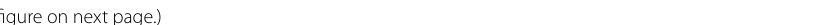
Fig. 2 A 32‑year‑old female diagnosed as RRMS showing multiple plaques; single voxel MR spectroscopy with ROI was placed at corona radiata plaque ( a ); showing decreased NAA curve and mildly elevated choline curve, which is correlated by Low NAA/Cr ratio 1.38 and elevated choline/ Cr ratio 1.09. b ROI was placed at NAWM, more lateral to the plaque showing decreased NAA curve and mildly elevated choline curve, which is correlated by Low NAA/Cr ratio 1.55 and elevated choline/Cr